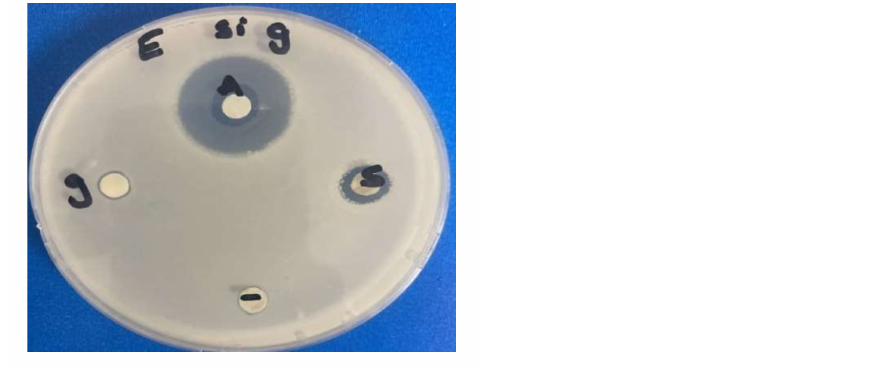
Figure 10. Inhibition zone of silver and gold nanoparticles of Chlorella vulgaris against E. coli .